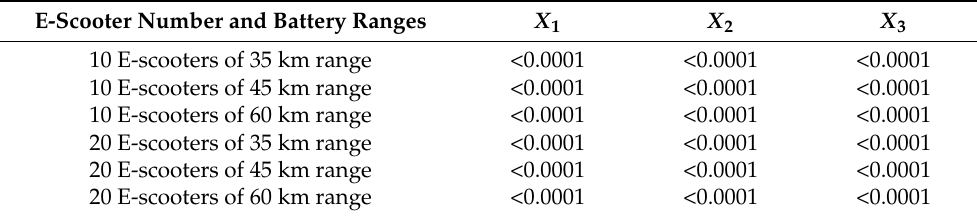
Table 5. p values of the scenario’s indicator variables for the HI models.